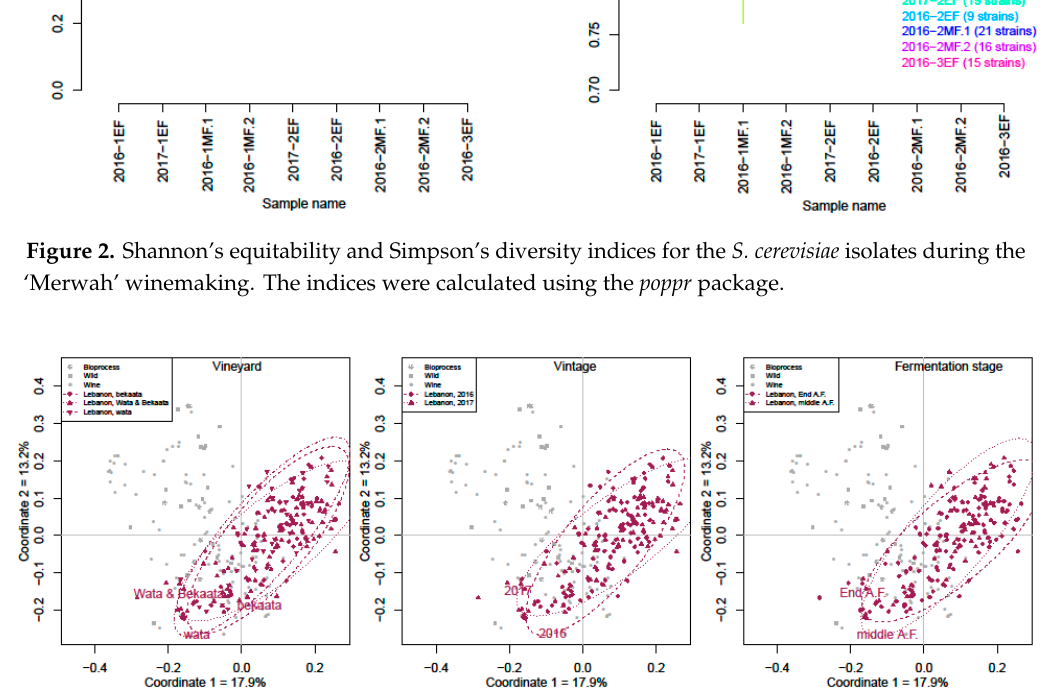
Figure 2. Shannon’s equitability and Simpson’s diversity indices for the S. cerevisiae isolates during the ‘Merwah’ winemaking. The indices were calculated using the poppr package.